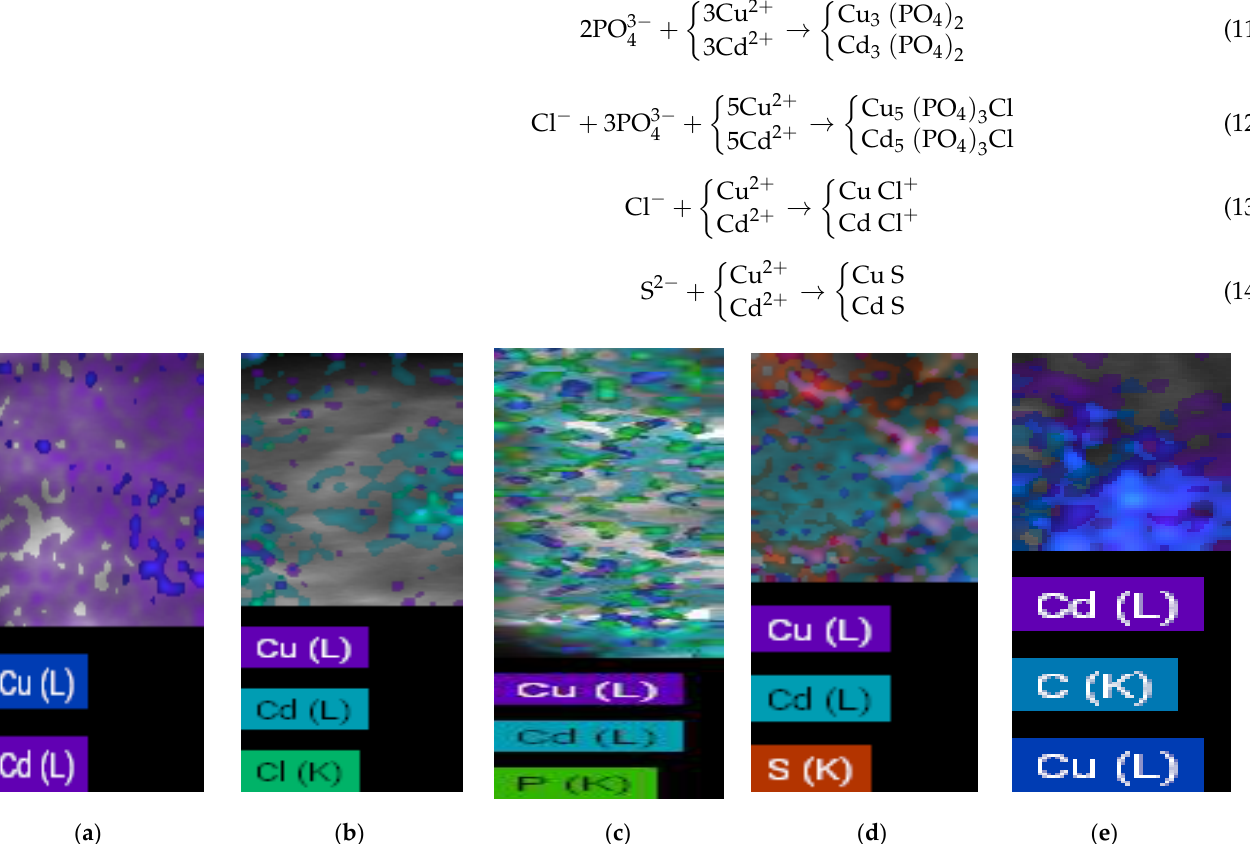
Figure 6. Copper and cadmium in Tunisian and Romanian soils ([Cu 2+ ] ≈ [Cd 2+ ] ≈ 0.1 mmol·L −1 ): ( a ) adsorption percentage; ( b ) capacity.